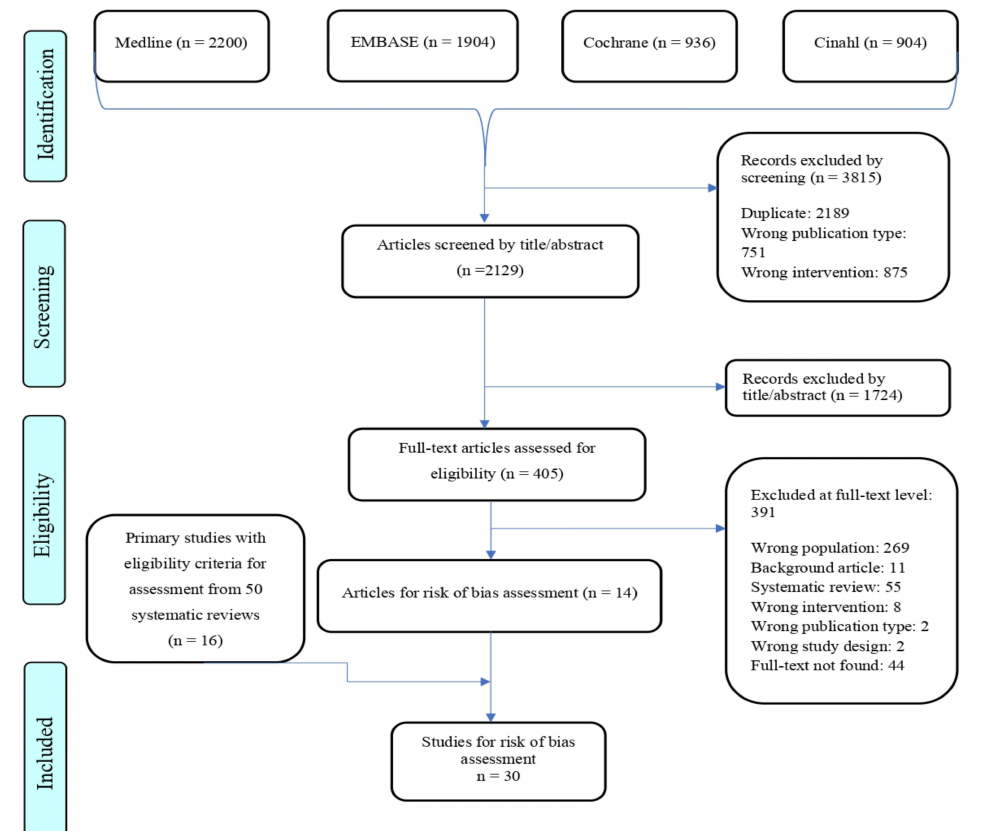
Figure 1. Study flow chart of studies evaluating clinical